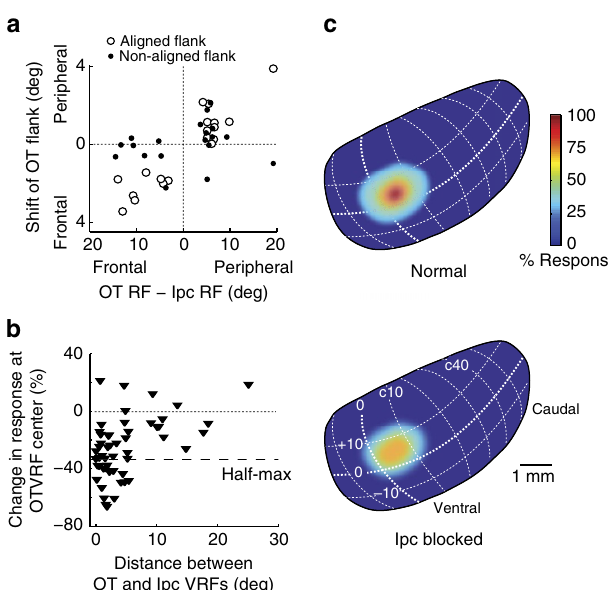
Figure 6 | Effect of Ipc blockade on population visual responses in the OT. ( a ) Population summary of the effect of Ipc blockade on the Ipc-aligned half-max response (open circles) and the Ipc-non-aligned half-max response (solid dots) for non-aligned OT–Ipc sites ( n ¼ 19). The directions of the shifts in half-max values are plotted as a function of the relative positions of the VRF centres for each OT–Ipc pair. ( b ) Extent of the blockade in the Ipc. The plot shows the effect of Ipc blockade on OTresponses at the VRF centre. The data compare the strength of OTunit responses ( n ¼ 52) to looming-dot stimuli (full contrast; 8 (cid:2) per s), measured at the centre of the OT VRF, before versus during Ipc blockade. This plot includes data from two OT–Ipc pairs for which the effect of blockade on the OT VRF centre was measured, but for which the effects on the entire OT tuning curve was not measured. Per cent change is plotted as a function of the distance, in degrees of space, between the OT and Ipc VRF centres. Dashed line indicates 50% of the maximum observed blockade effect (69% response reduction). ( c ) Illustration of the average population visual response across the OTspace map, measured relative to the maximum response before Ipc blockade (colour bar; Methods). The drawings represent a lateral view of the space map on the surface of the OT 39 . Top: before Ipc blockade (Ipc connected); bottom: during Ipc blockade (Ipc